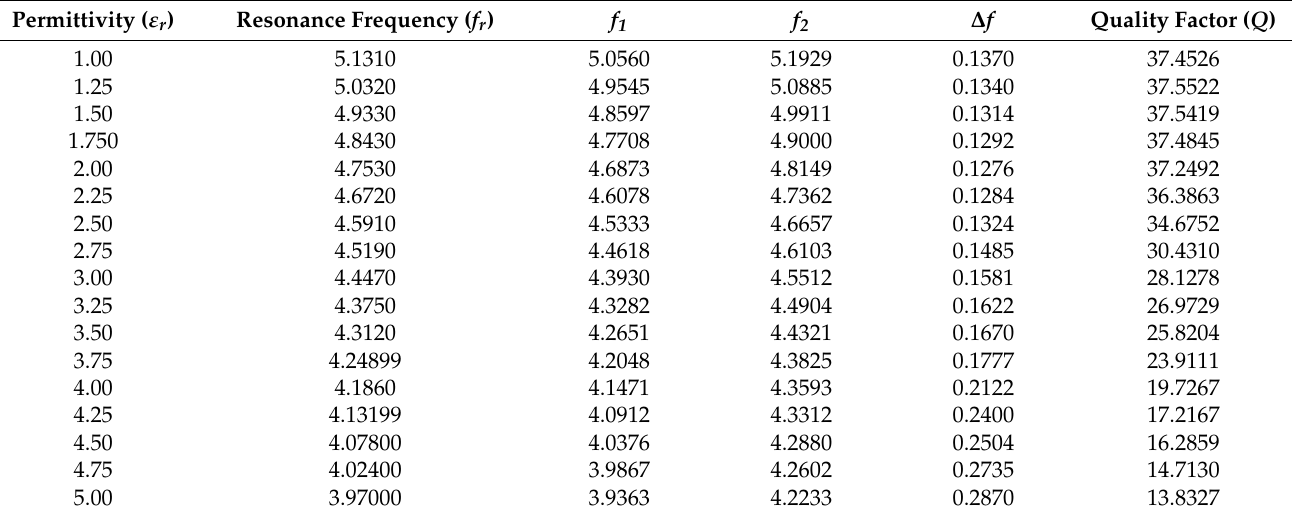
Table 3. Quality factor for the designed